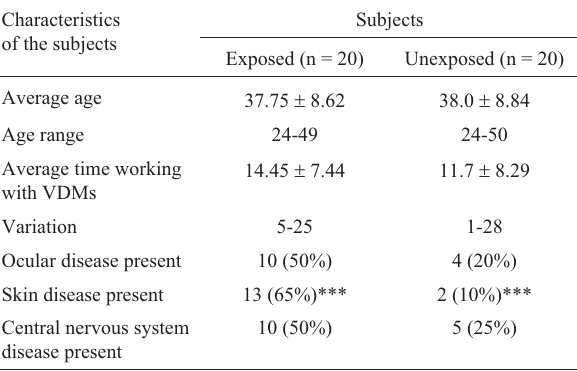
monitors (VDMs) as compared to unexposed control individuals matched for age and